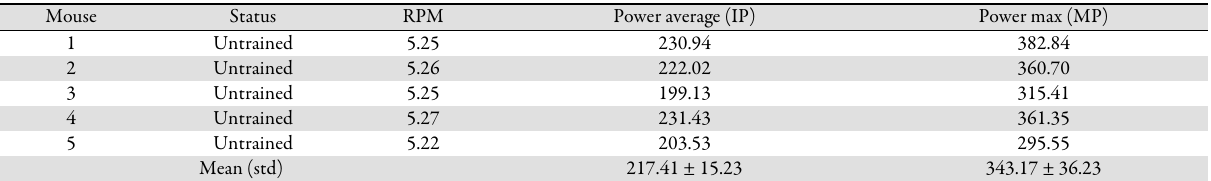
Table 4. Data for the untrained (control) group at effort activity for 20 minutes